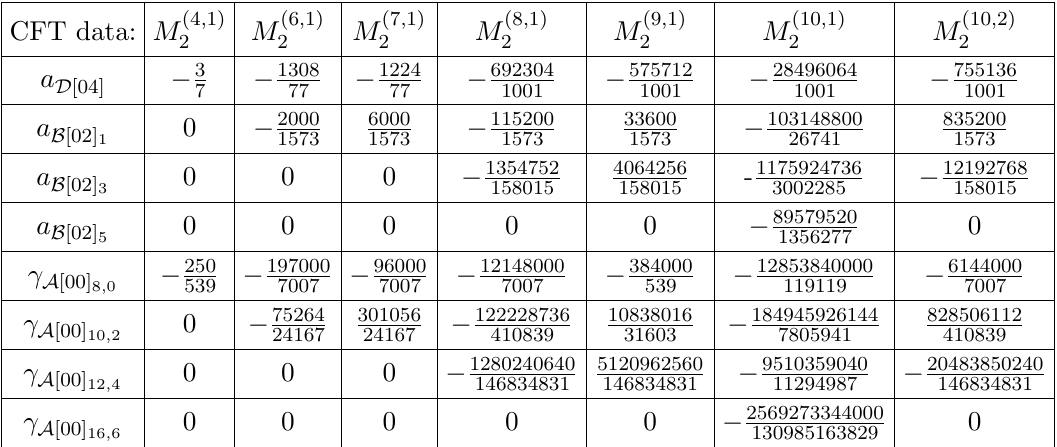
. The 2 ; poly in (3.14). The entries 2 ; poly , the overall coe(cid:14)cient of M ( p;i ) . Upon (cid:12)xing the B ( p;i ) 2 2 2 ; poly